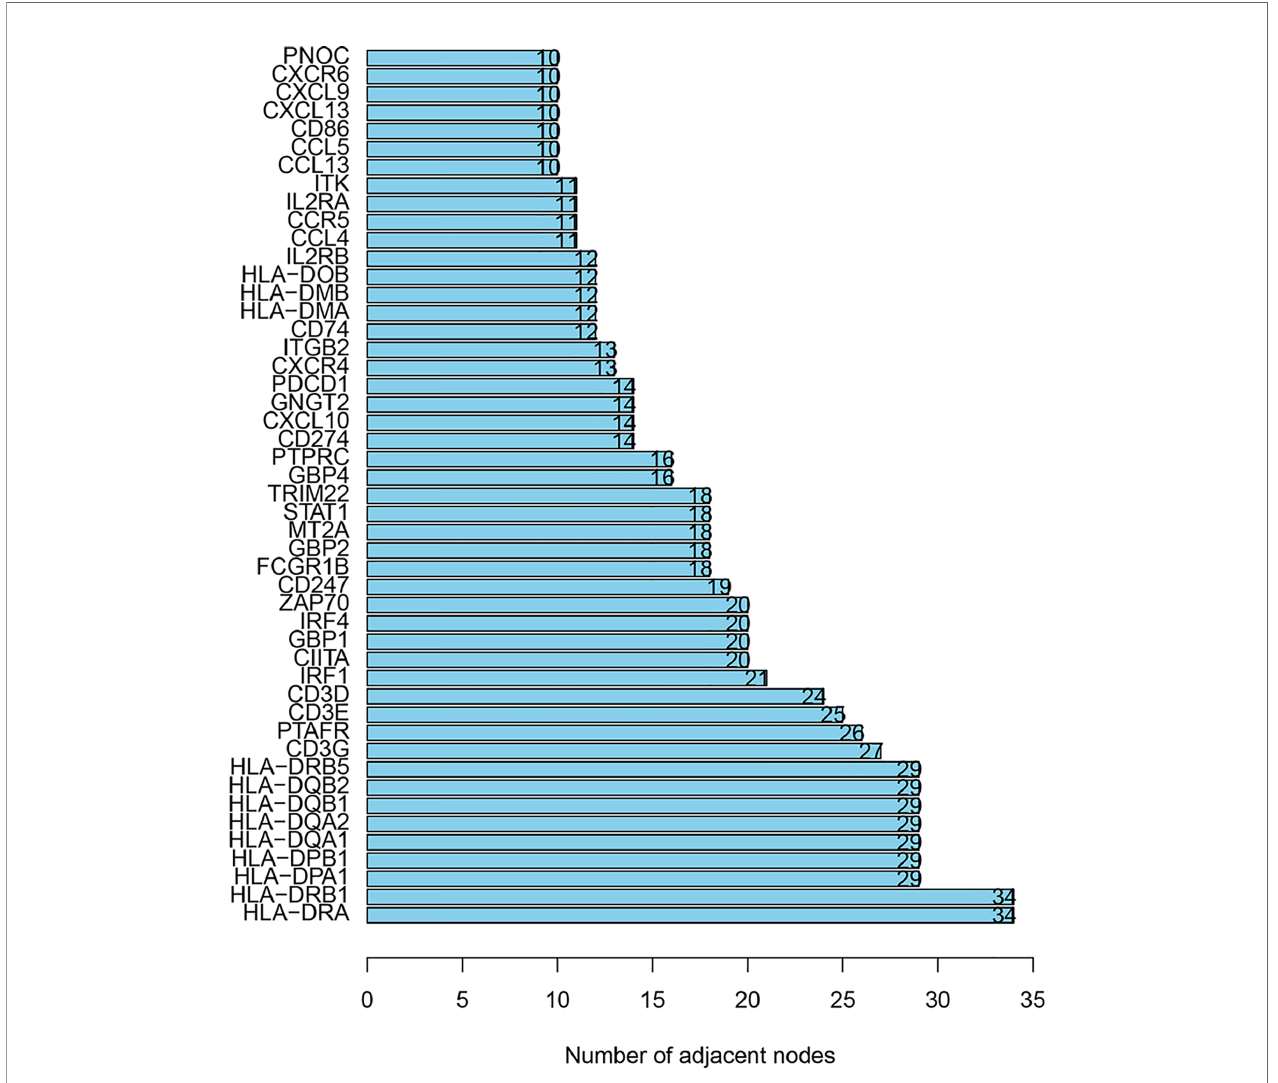
FIGURE 6 | The genes with more than 10 interaction nodes in the PPI analyses. PPI, protein-protein